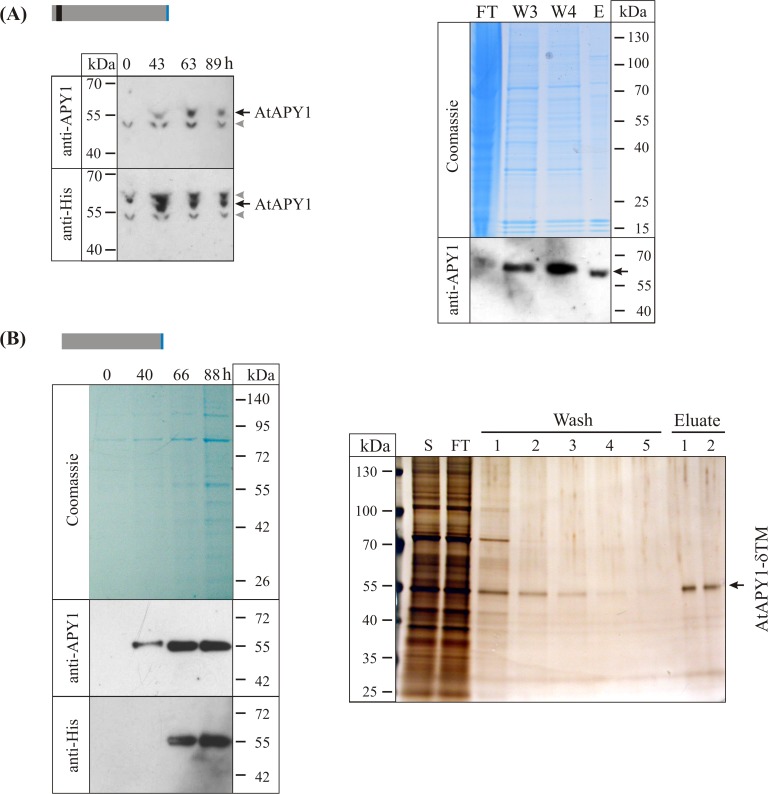
Purification of AtAPY1 and AtAPY1-δTM.The explanation of the colors in the schematic representations of AtAPY1 and AtAPY1-δTM can be found in Fig. 2. (A) Total proteins from 1.6 x 105 HEK293 cells were harvested at each of the indicated time points post transfection with AtAPY1 DNA, separated in a 4–12% gradient gel under denaturing conditions, transferred onto a PVDF membrane and successively incubated with anti-APY1 and anti-His antibodies (left panel). The black arrows mark the signal specific for AtAPY1, while the gray arrowheads indicate unspecific bands. The right panel shows the total protein extract from 1.4 x 108 HEK293 cells harvested at 89 h after transfection with AtAPY1 DNA subjected to Ni2+-affinity chromatography. Various fractions were separated in a 4–12% gel under denaturing conditions and either stained with Coomassie or transferred onto a PVDF membrane for Western blot analysis. The black arrow indicates the signal detected with antibodies against AtAPY1. The volumes loaded were 1/480 of the flow through (FT) fraction, 1/50 of each of the final two wash fractions W3 and W4 and 1/100 of the elution fraction E. (B) The left panel shows samples representing equal volumes (1/3,000) of the culture medium of 1 x 108 HEK293 cells taken at the indicated time points post transfection with AtAPY1-δTM DNA and separated in a 4–12% gradient gel under denaturing conditions. Subsequently, the proteins were either stained with Coomassie or blotted onto a PVDF membrane for Western blot analysis. The right panel depicts the culture medium of 4 x 107 HEK293 cells at time point 88 h after transfection with AtAPY1-δTM DNA subjected to Ni2+-affinity chromatography. A gradient gel (4–12%) was loaded with 20 μL of supernatant (S) and 20 μL of flow through (FT), 10 μL of each wash 1–5 and 10 μL of each eluate 1–2. For total volumes of the individual fractions see Materials and Methods. The protein amount loaded for eluate 1 equals about 70 ng. Following SDS-PAGE, the gel was silver-stained.